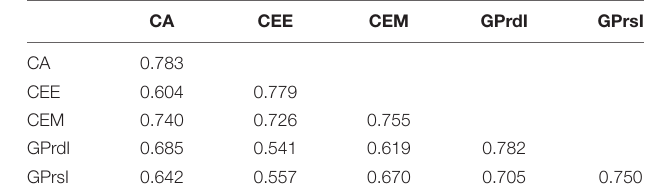
TABLE 2 | Fornell–Larcker criterion.